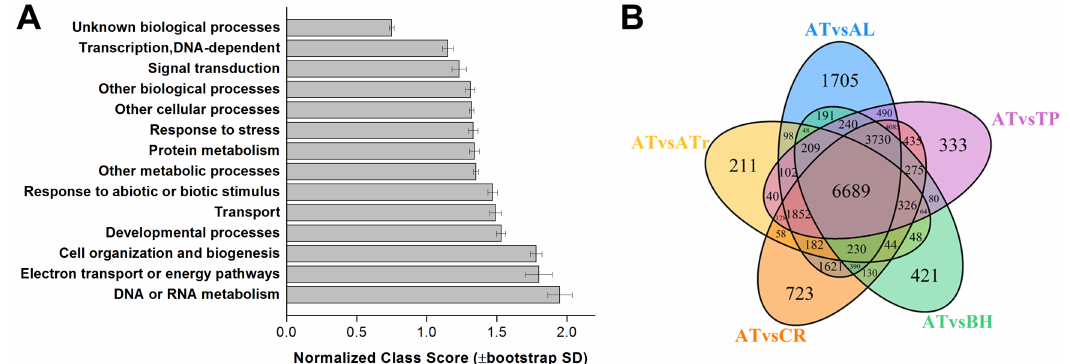
Fig 3. Results of GO enrichment analysesof 6,689 conservedgenes in B . humilis . GO enrichedterms ( p < 0.01) were analyzedusing the Classification SuperViewer Tool and normalized(A) results are presented. (B) Venn diagram representation to show the conservedgenesbetween B . humilis and the other five other sequencedspecies. Abbreviations: AT, A . thaliana ;AL, A . lyrata ; CR, C . rubella ;TP, T . parvula ;ATr, A . trichopoda .